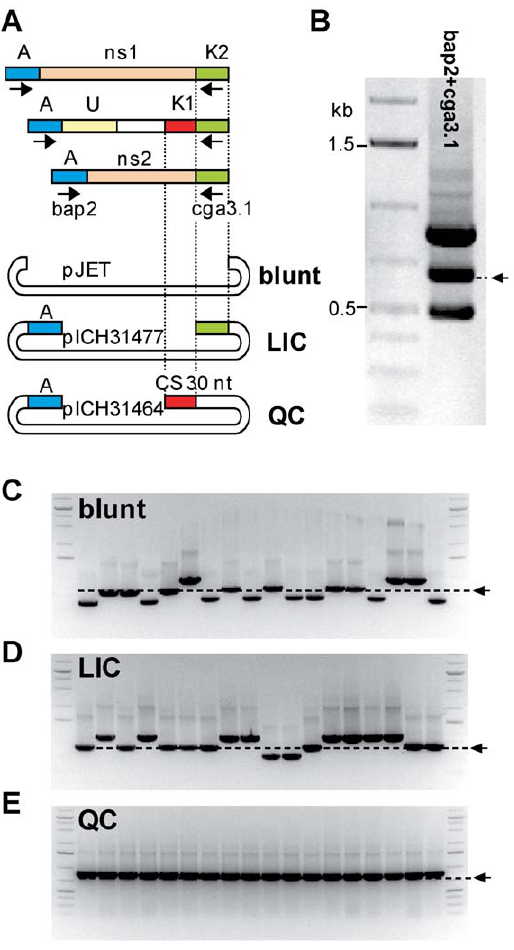
Figure 6. Comparison of blunt-end cloning, ligation-indepen- dent cloning and QC cloning using a mix of defined PCR products. ( A ) To compare efficiency of the three cloning methods, a mixture of three PCR products, two unspecific (ns1 and ns2) and one immunoglobulin fragment, was cloned (A, adaptor; U, unknown sequence; K, known sequence; ns, non-specific; CS, catching sequence). ( B ) PCR product mix amplified using primers bap2 pc and cga3.1. The arrow indicates the immunoglobulin fragment. ( C, D, E ) 12 randomly chosen clones for each cloning strategy were analyzed by colony PCR using vector primers. The immunoglobulin insert size is indicated by an arrow and a dashed line. ( C ) Unspecific blunt-end cloning into pJET1.2. ( D ) ligation-independent cloning into pICH31477 using a CS identical to cga3.1. ( E ) QC cloning into pICH31464.